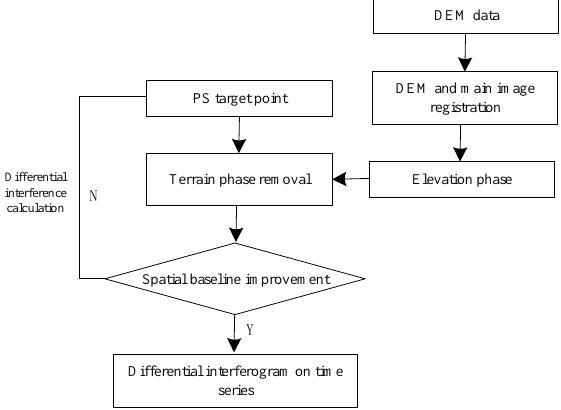
Figure 4. Flow chart of differential interference